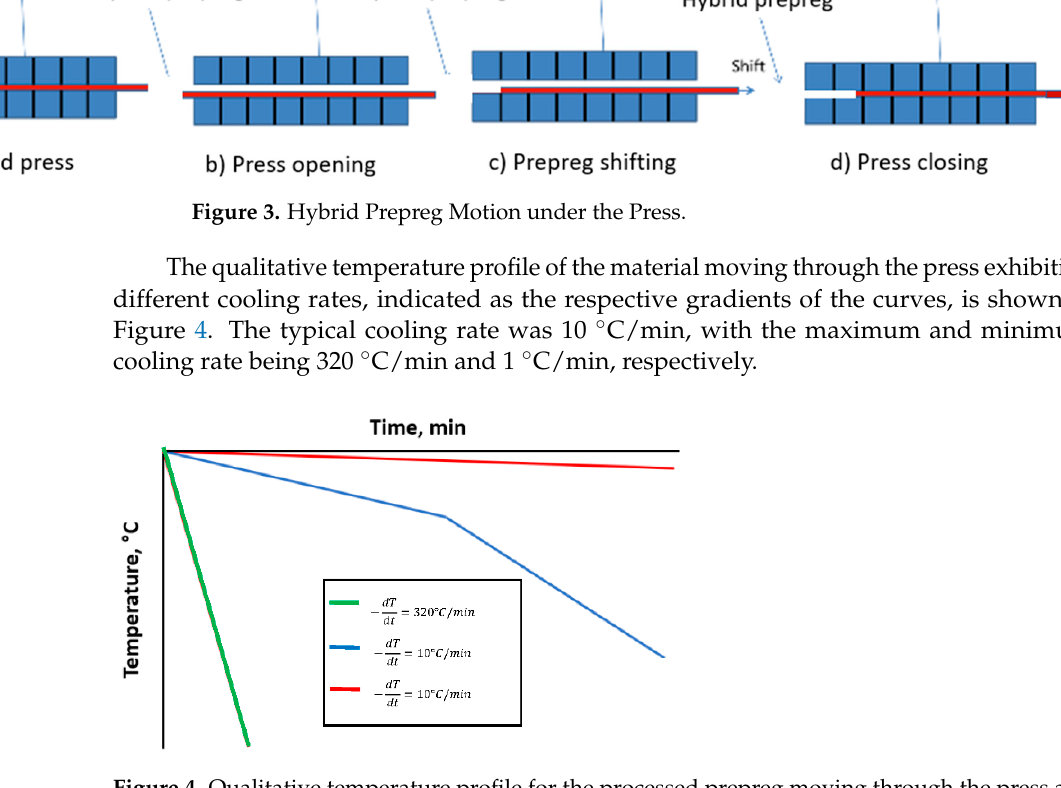
Figure 4. Qualitative temperature profile for the processed prepreg moving through the press and for different cooling rates applied.